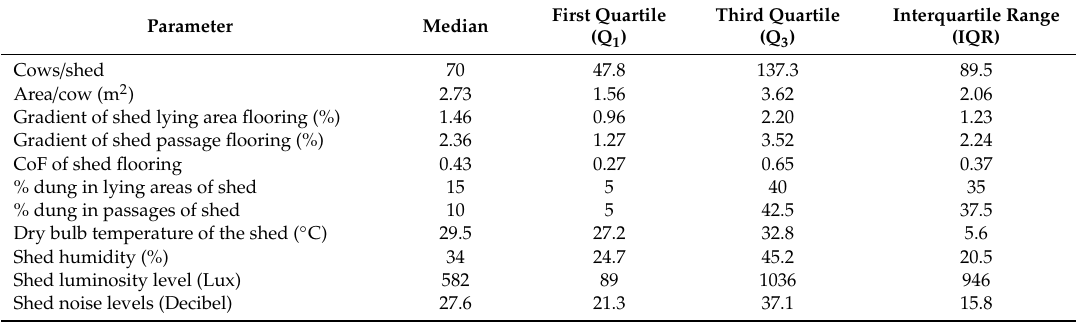
Table 2. Descriptive statistics of shelter-based resource measures ( n = 54).